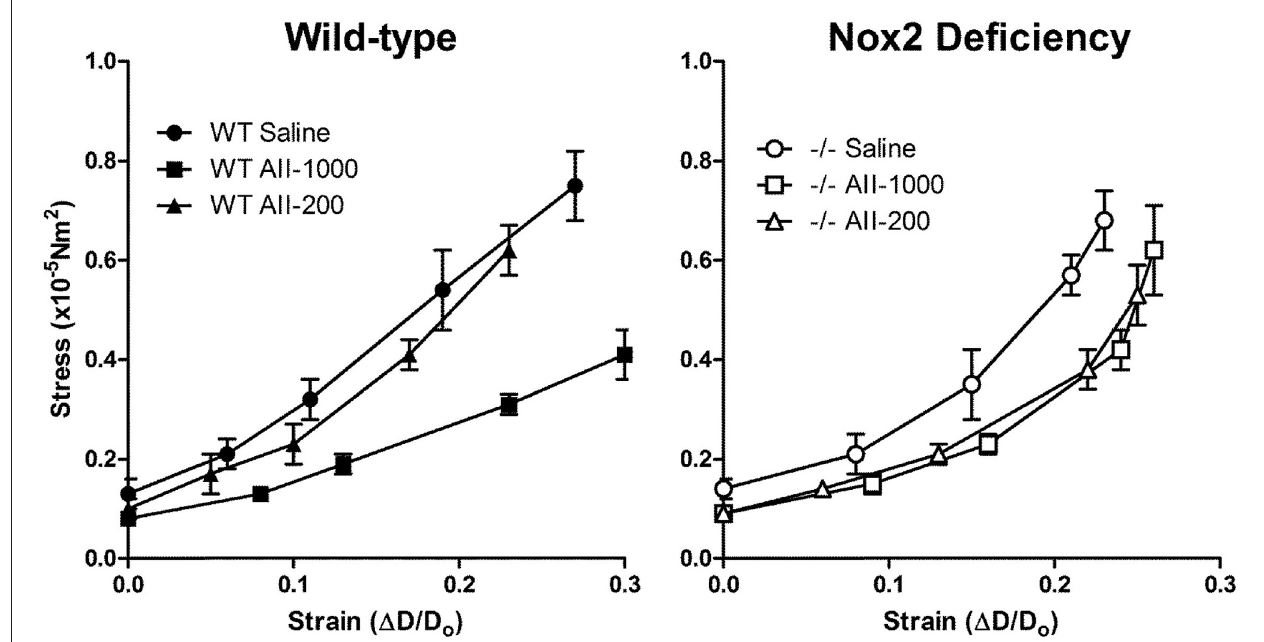
FIGURE 4 | Stress-strain relationships in maximally dilated cerebral arterioles in wild-type (WT) and Nox2-deficient ( − / − ) mice treated with a pressor (AII-1000) or a non-pressor (AII-200) dose of angiotensin II or saline. Data are presented as mean ± SEM of 10